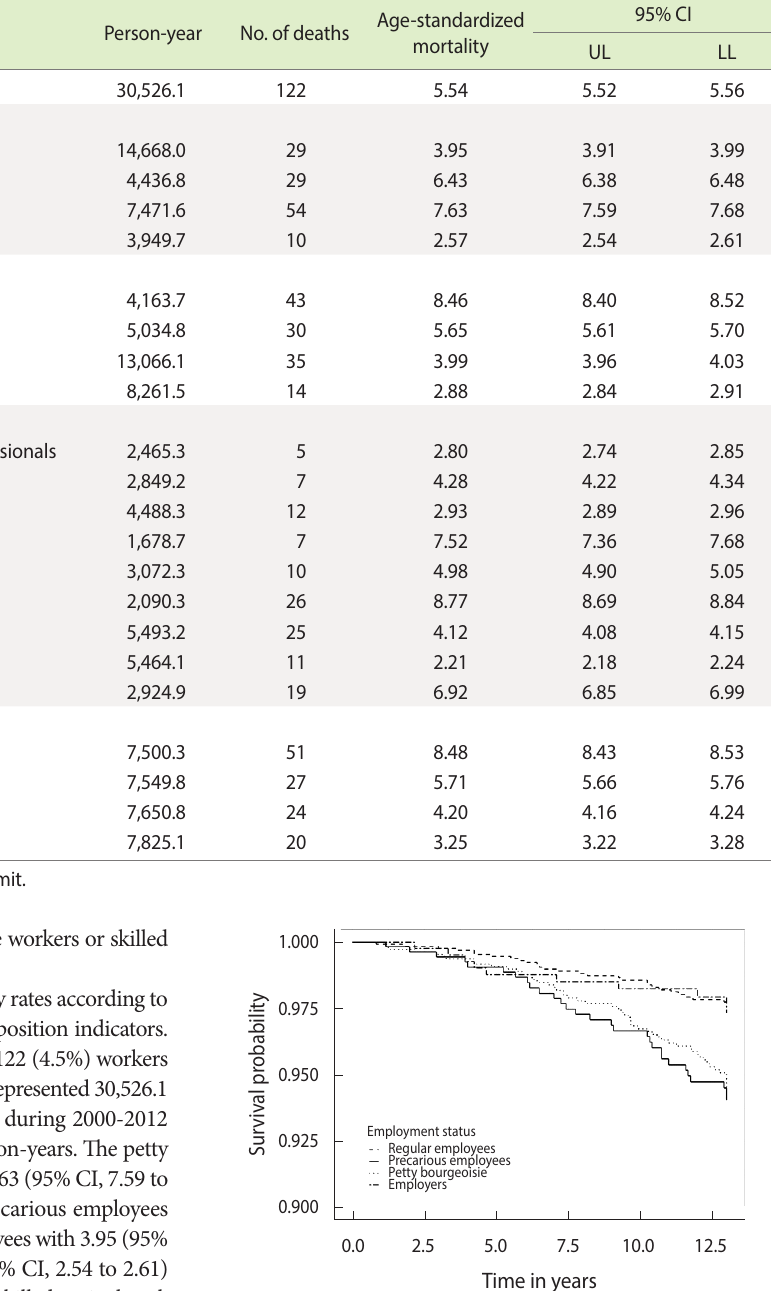
Figure 1. Survival graphs 1 for mortality for 13 years by employment status in 1999. 1 Adjusted